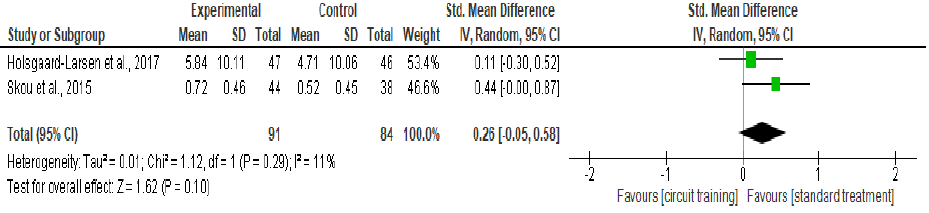
Figure 8. Forest plot analysis of the effect of CT on health-related quality of life [42,43]. Knee Symptom